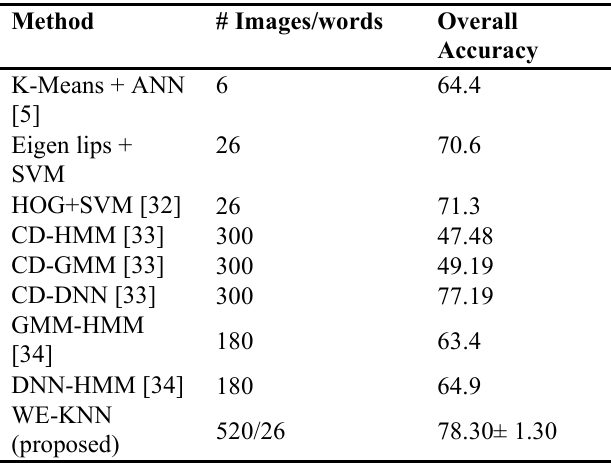
Table 3. Comparison with state-of-the-art